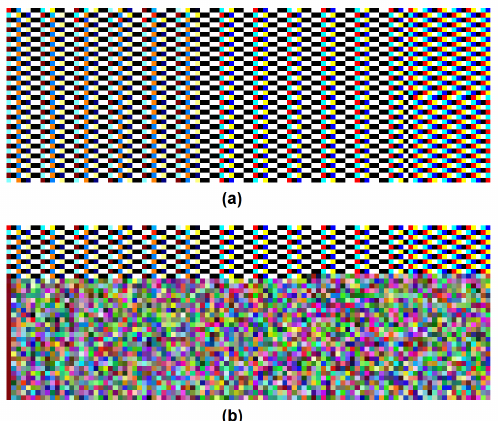
Figure 1. Decompressed hyperspectral image ( a ) without errors ( b ) corrupted by a malfunction error during the compression